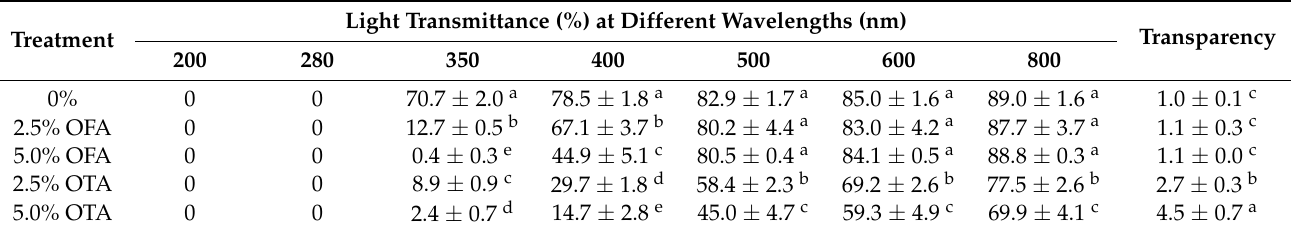
Table 3. Light transmittance and transparency of oxidized ferulic (OFA) and tannic (OTA) acid-treated WPI films. Light Transmittance (%) at Different Wavelengths Treatment